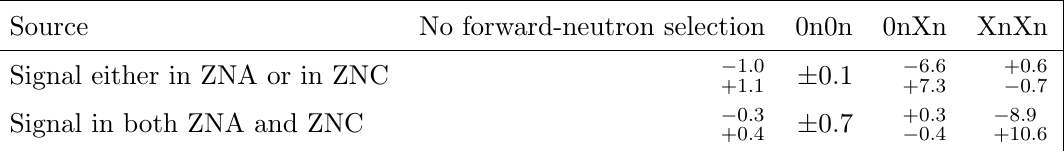
Table 2 . Summary of the systematic uncertainties on the cross sections related to the correction factors to account for the events with neutrons which are vetoed by the AD or V0 detectors. See text for details. The numbers correspond to the variations of the cross sections in per